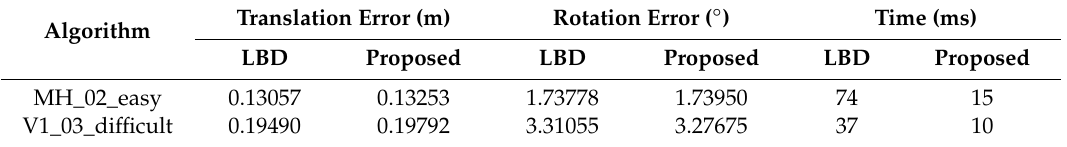
Table 1. Comparison of LBD descriptor matching method and the matching method we proposed.